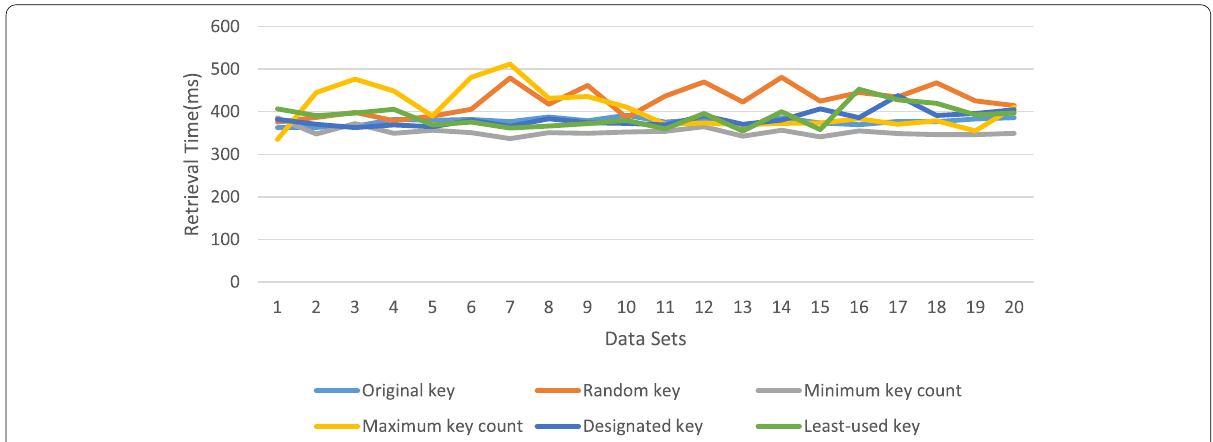
Fig. 9 Retrieval time on primary index models of the six key selection methods with equal appearing probabilities of parameters